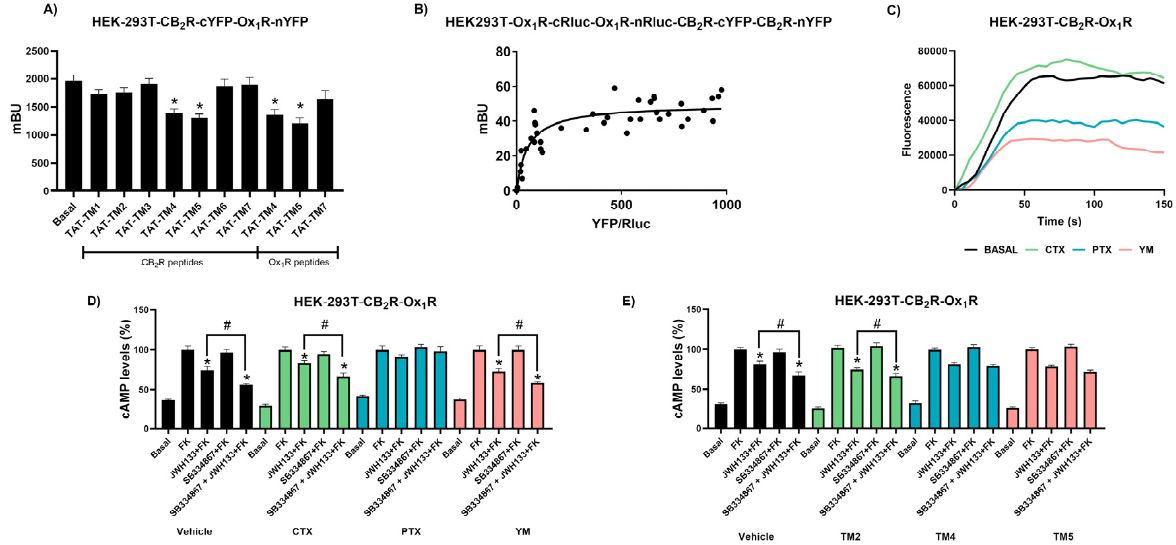
Figure 3. Transmembrane domains involved in the OX 1 R-CB 2 R interaction. ( A ) Bimolecular comple- mentation experiments were determined in HEK-293T cells coexpressing OX 1 R-nYFP (1.5 µ g) and CB 2 R-cYFP (1.5 µ g) and treated for 4 h with interfering peptides having sequences with homologies to transmembrane (TM) domains (0.4 µ M). Values represent the mean ± SEM of eight independent experiments. A statistical analysis was performed using a one-way ANOVA followed by Bonferroni’s post hoc test (* p < 0.05 versus basal condition). ( B ) BRET assays were determined in cells expressing a constant amount of cDNA for OX 1 R-cRluc (1.5 µ g) and OX 1 R-nRluc (1.5 µ g) and increasing amounts of cDNA for CB 2 R-cYFP (0.3–2.5 µ g) and CB 2 R-nYFP (0.3–2.5 µ g). ( C ) HEK-293T cells expressing CB 2 R, OX 1 R and the engineered calcium sensor, GCaMP6 (1 µ g) were incubated overnight with vehi- cle or pertussis toxin (PTX; 10 ng/mL), or for 2h with cholera toxin (CTX; 100ng/mL) or YM254890 (YM; 100ng/mL) and exposed to orexin-A (100 nM). Cytosolic calcium readings were collected, and data from a representative experiment are shown. ( D ) HEK-293T cells expressing the receptors were incubated overnight with vehicle or pertussis toxin (PTX; 10ng/mL), or for 2h with cholera